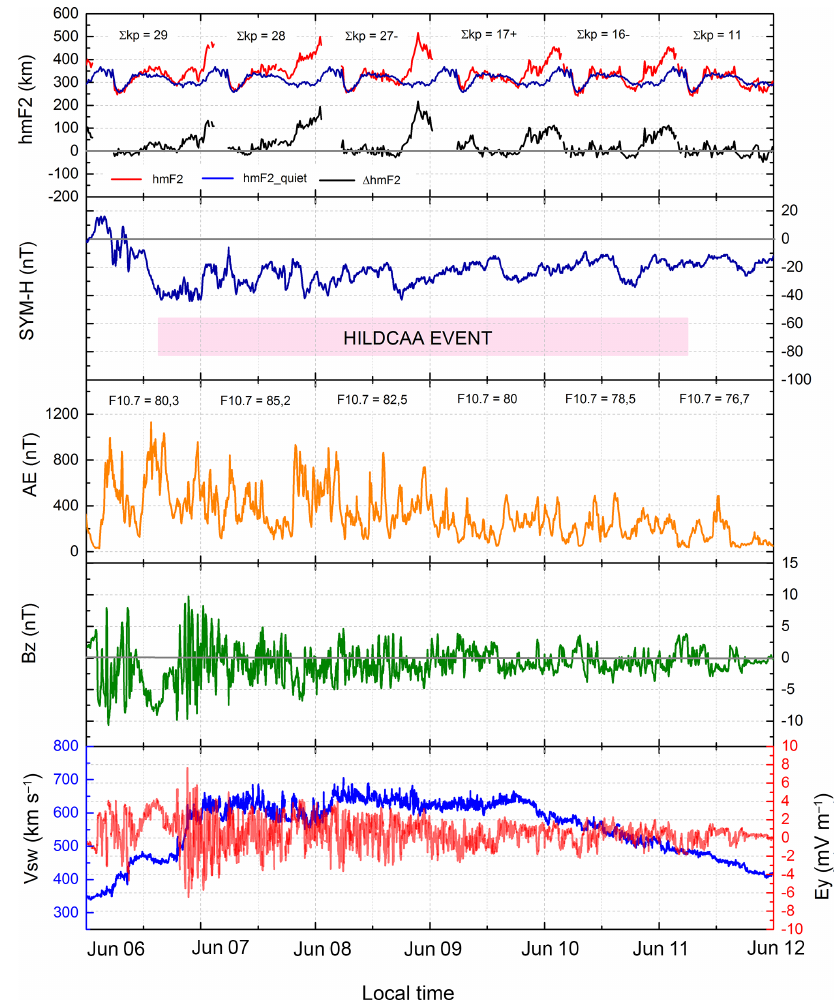
Figure 2. Same as Fig. 1 but for the HILDCAA event that occurred during 6–11 June 2006 (H-06).